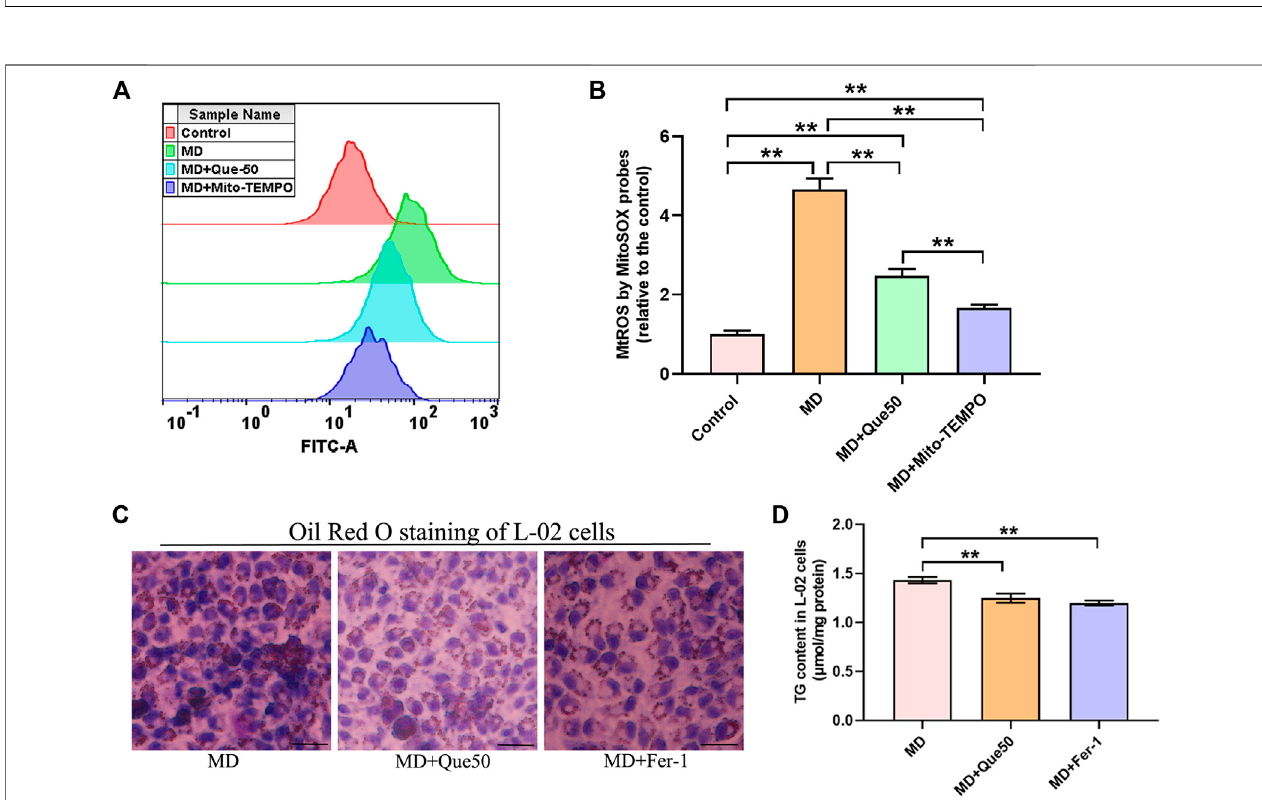
FIGURE6| QuereducedMtROSandlipiddepositioninsteatoticL-02cells( n =3). (A) Representative fl uorescenceintensityimagesofMtROSbyMitoSOXprobes obtained by fl ow cytometry. (B) Flow cytometric analysis of fl uorescence intensity. (C) Oil Red O staining of L-02 cells (scale bar = 50 μ m). (D) TG content in L-02 cells. The data are expressed as the mean ± SD from three independent experiments. **, p < 0.01 and *, p < 0.05.